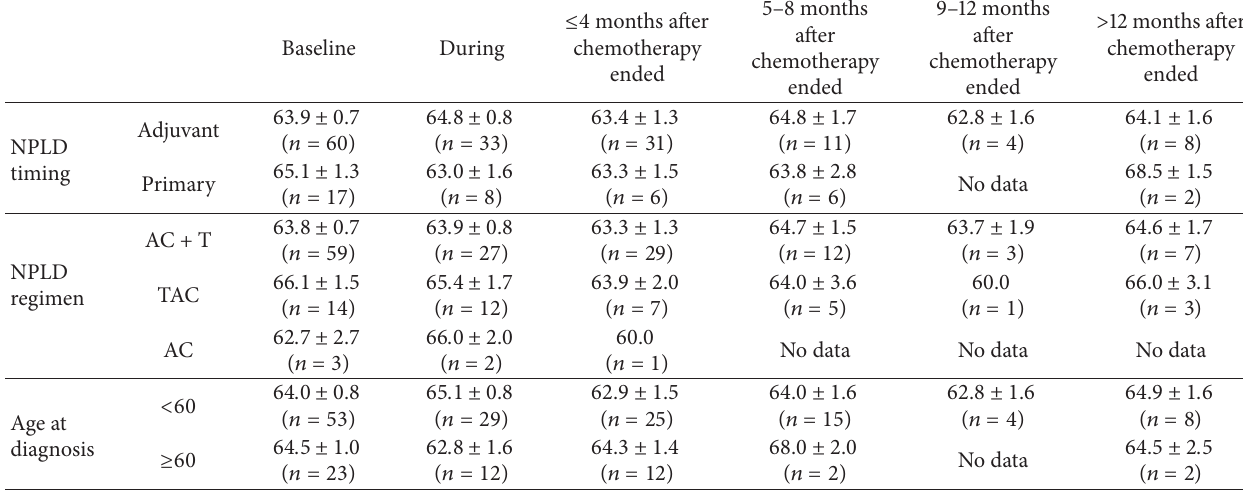
Table 2: Mean ( ± standard error) LVEF (%) values according to timing of NPLD, regimen used, and age at